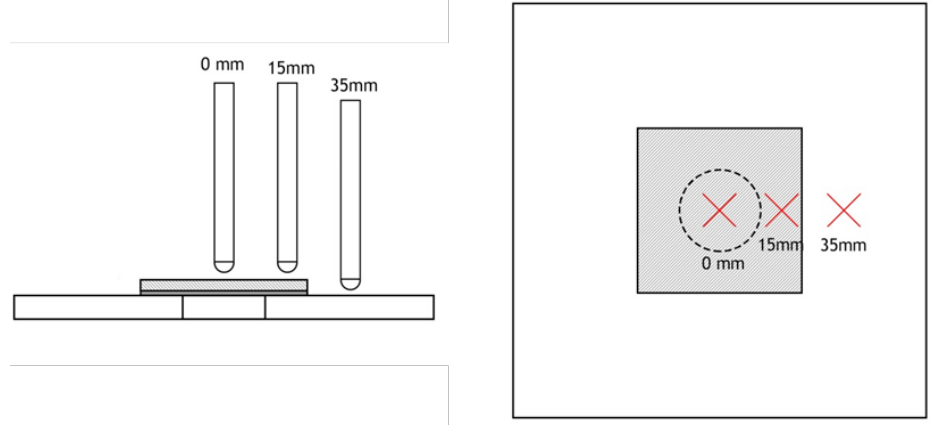
Figure 2. Location of the three impact points.